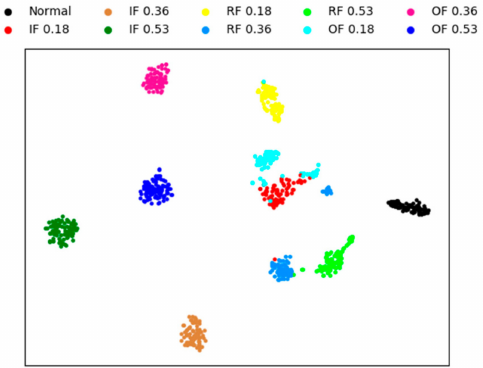
Figure 10. Visualization of weight average for the learned features.